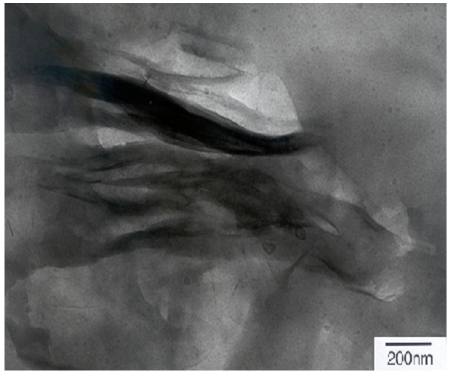
Figure 3. TEM (transmission Electron Microscopy) image of the Ln@AC nanocomposite.